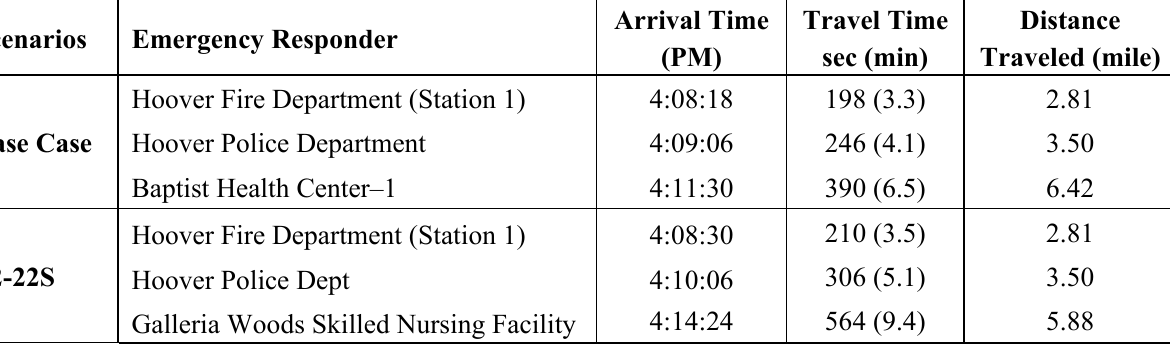
Table 8. First emergency responders arrival times and travel